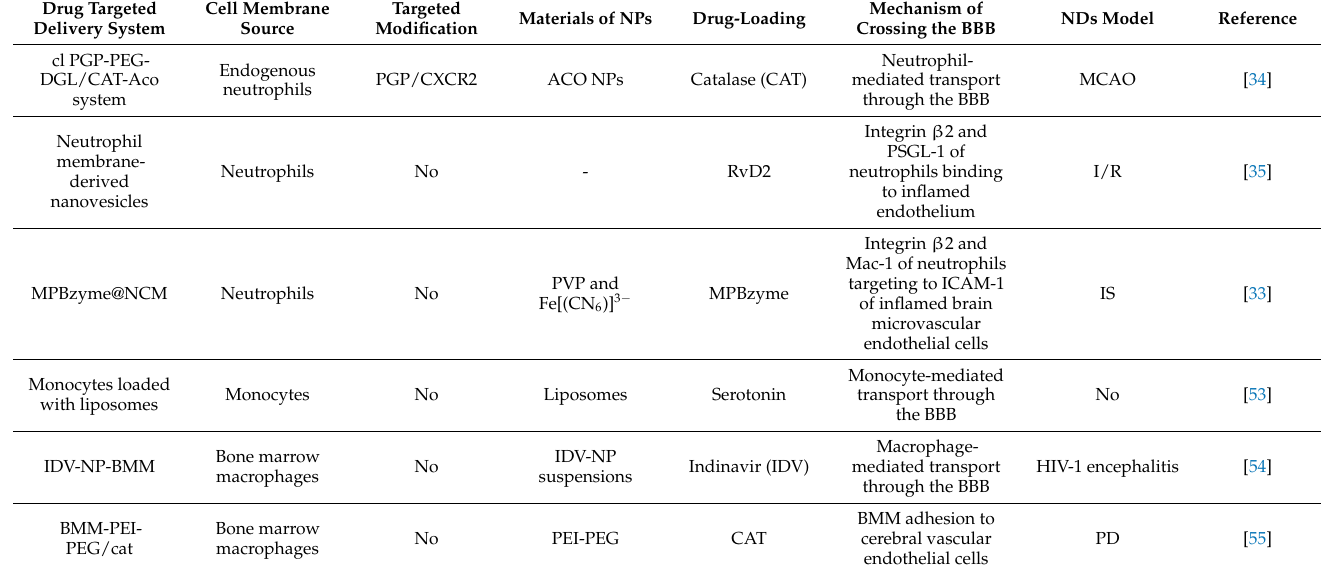
Table 1. Summary of white-cell-membrane-coated nanoparticles for ND drug delivery.